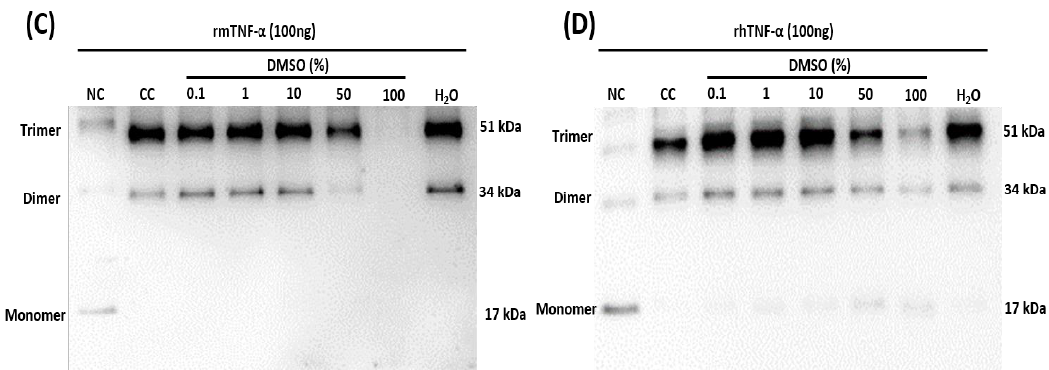
Figure 3. Inhibition of TNF- α -dependent signaling pathways by disruption of the oligomeric form. ( A , B ) The inhibition of NF- κ B and MAPK-signaling pathways by DMSO (100%) was evaluated by treating L929 cells ( A ) and HDFs ( B ) at the indicated time points with either TNF- α only or DMSO preincubated for 1 h with rhTNF- α . ( C , D ) Disruption of homotrimerization of recombinant mouse TNF- α (rmTNF- α ( C )) and recombinant human TNF- α (rhTNF- α ( D )) after the treatment with DMSO was evaluated. Human and mouse TNF- α were incubated with DMSO, chemically cross-linked, and subjected to Western blotting. NC = non-cross-linked control (no cross-linker, no inhibitor); CC = cross-linked control (no inhibitor). The blots were visualized on a ChemiDoc ™ Touch Imaging System (Bio-Rad Laboratories).